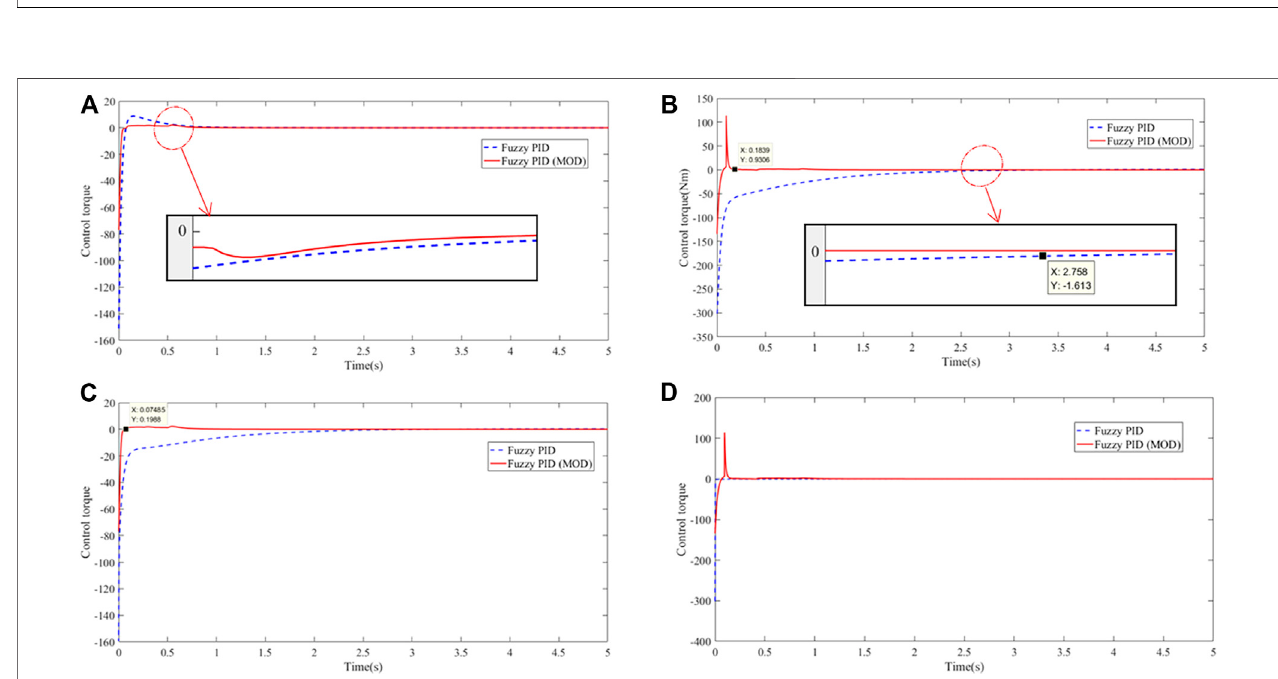
FIGURE 14 | Control torque input curve of the manipulator: (A) joint 1, (B) joint 2, (C) joint 3, and (D) joint 4.